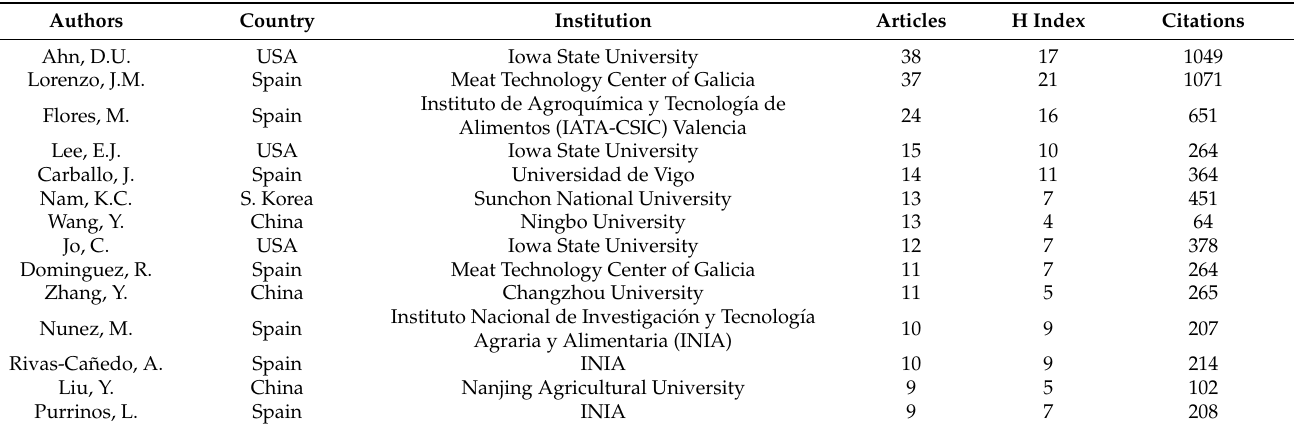
Table 4. The most productive authors according to the number of articles published, the H-index and total citations of those